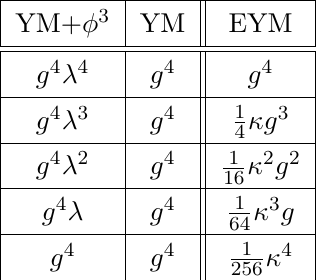
Table 1 . In four-point one-loop amplitudes of YM ⊗ (YM + φ 3 ) = EYM , the couplings g and λ on the left-hand side of the double copy are mapped to the following powers of the couplings κ and g in EYM via